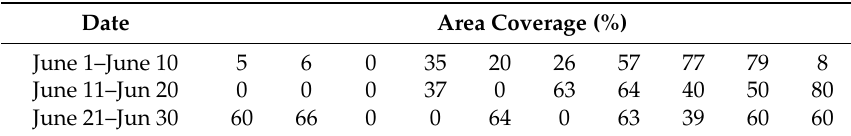
Table 3. Area coverage from Planet in June.